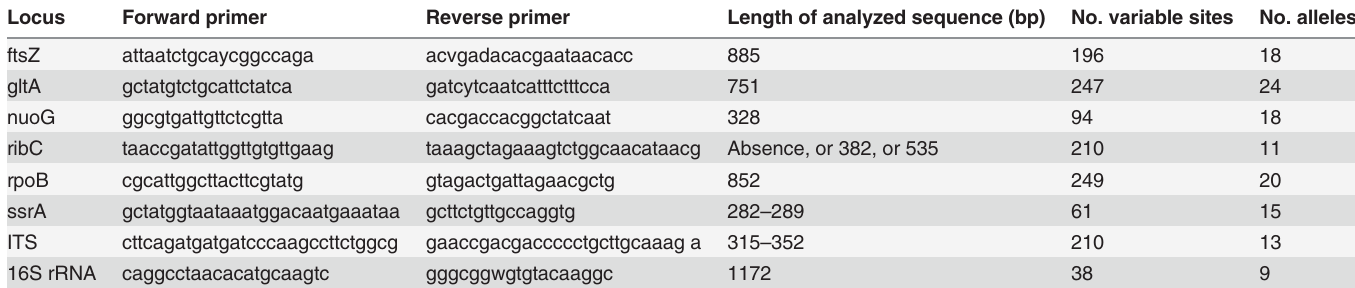
Table 2. Characteristics of the eight loci evaluated for the straw-colored fruit bat ( Eidolon helvum )-associated Bartonella MLST scheme. Locus Forward primer Reverse primer Length of analyzed sequence (bp)